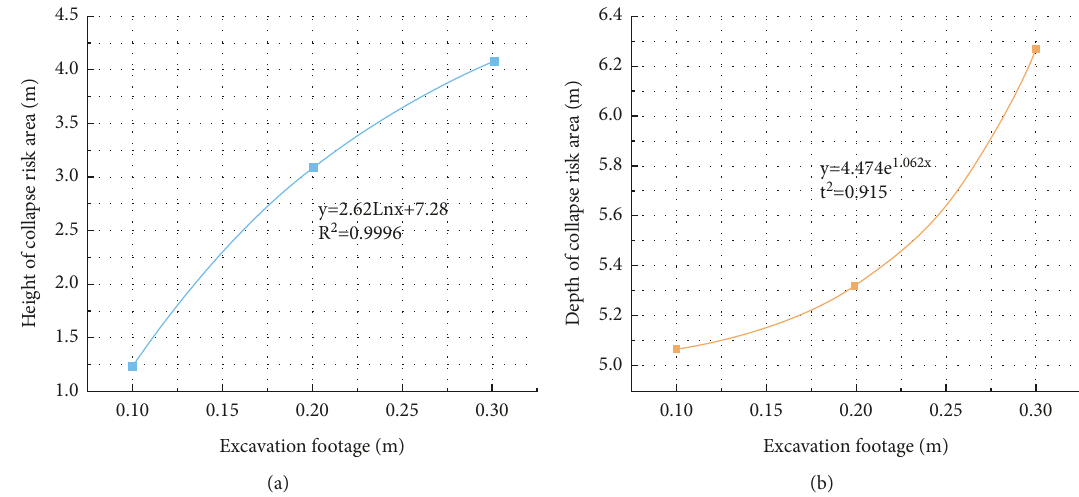
Figure 10: The development law of the collapse risk zones for different footages: (a) height distribution law of the collapse risk zones; (b) depth distribution law of the collapse risk